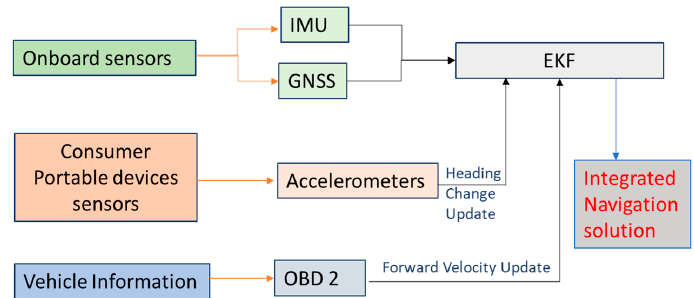
Figure 1. Consumer Portable devices/on-board navigation sensor integration architecture.